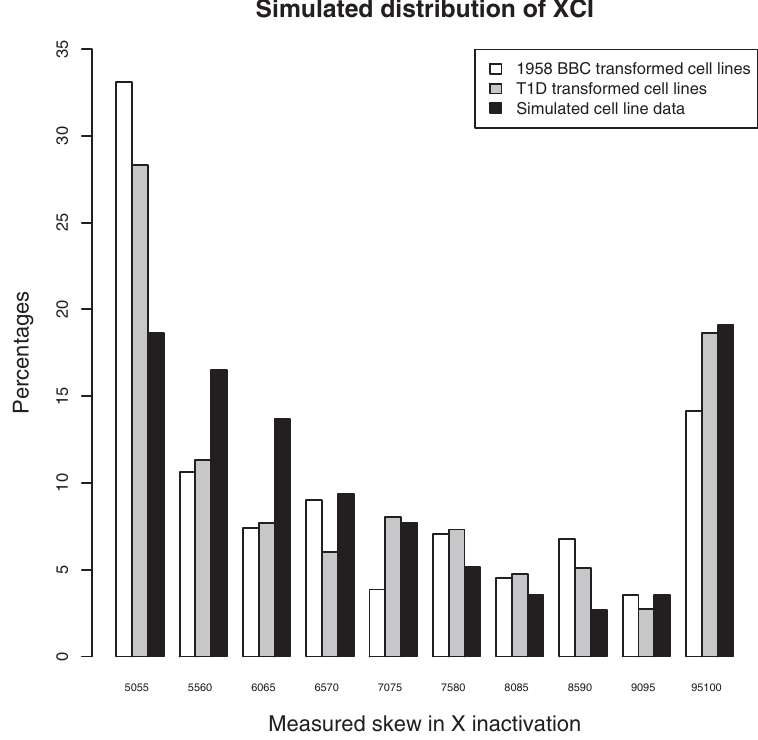
Figure 4. Simulation study comparing the XCI between our best fitting scenario and both sets of cell line (1958 British Birth Cohort and T1D samples).